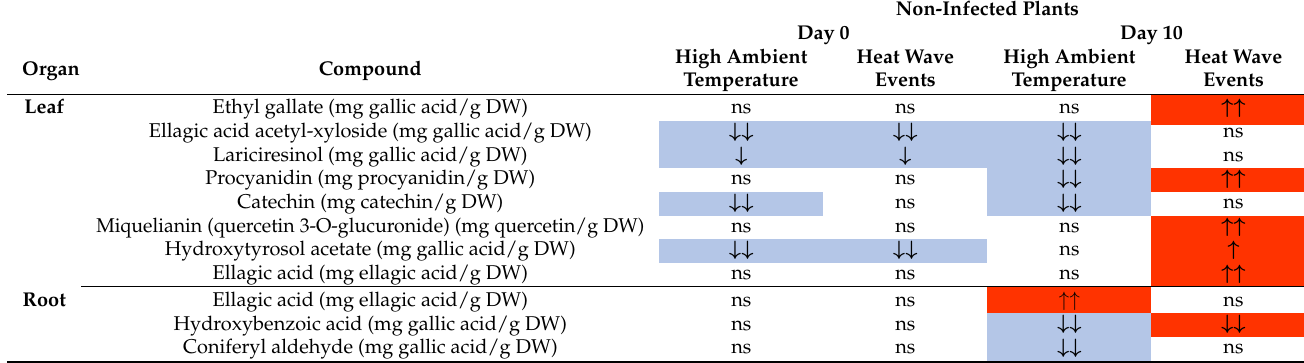
Table 3. Changes in phenolic compounds in leaves and roots of Castanea sativa seedlings 0 and 10 days after exposure of plants to high ambient temperature and heat wave events compared to plants exposed to ambient temperature. Red and blue indicate increase and decrease, respectively. Two arrows indicate significant variation ( p < 0.05), one arrow indicates marginally significant variation ( p < 0.10), and ns indicates non-significant variation (Tukey’s HSD test).